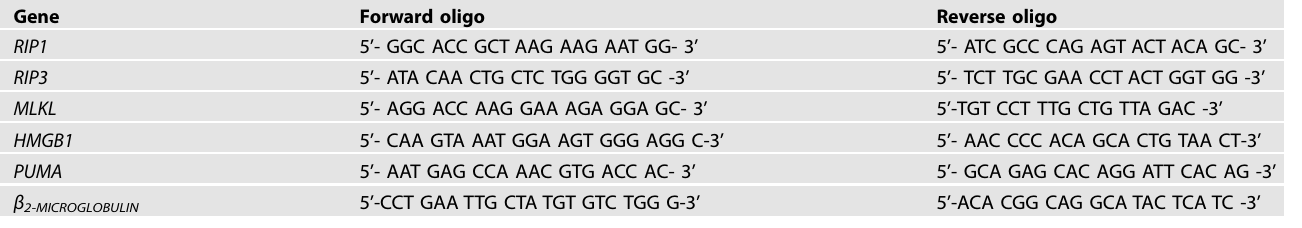
Table 2. List of primers used. Gene